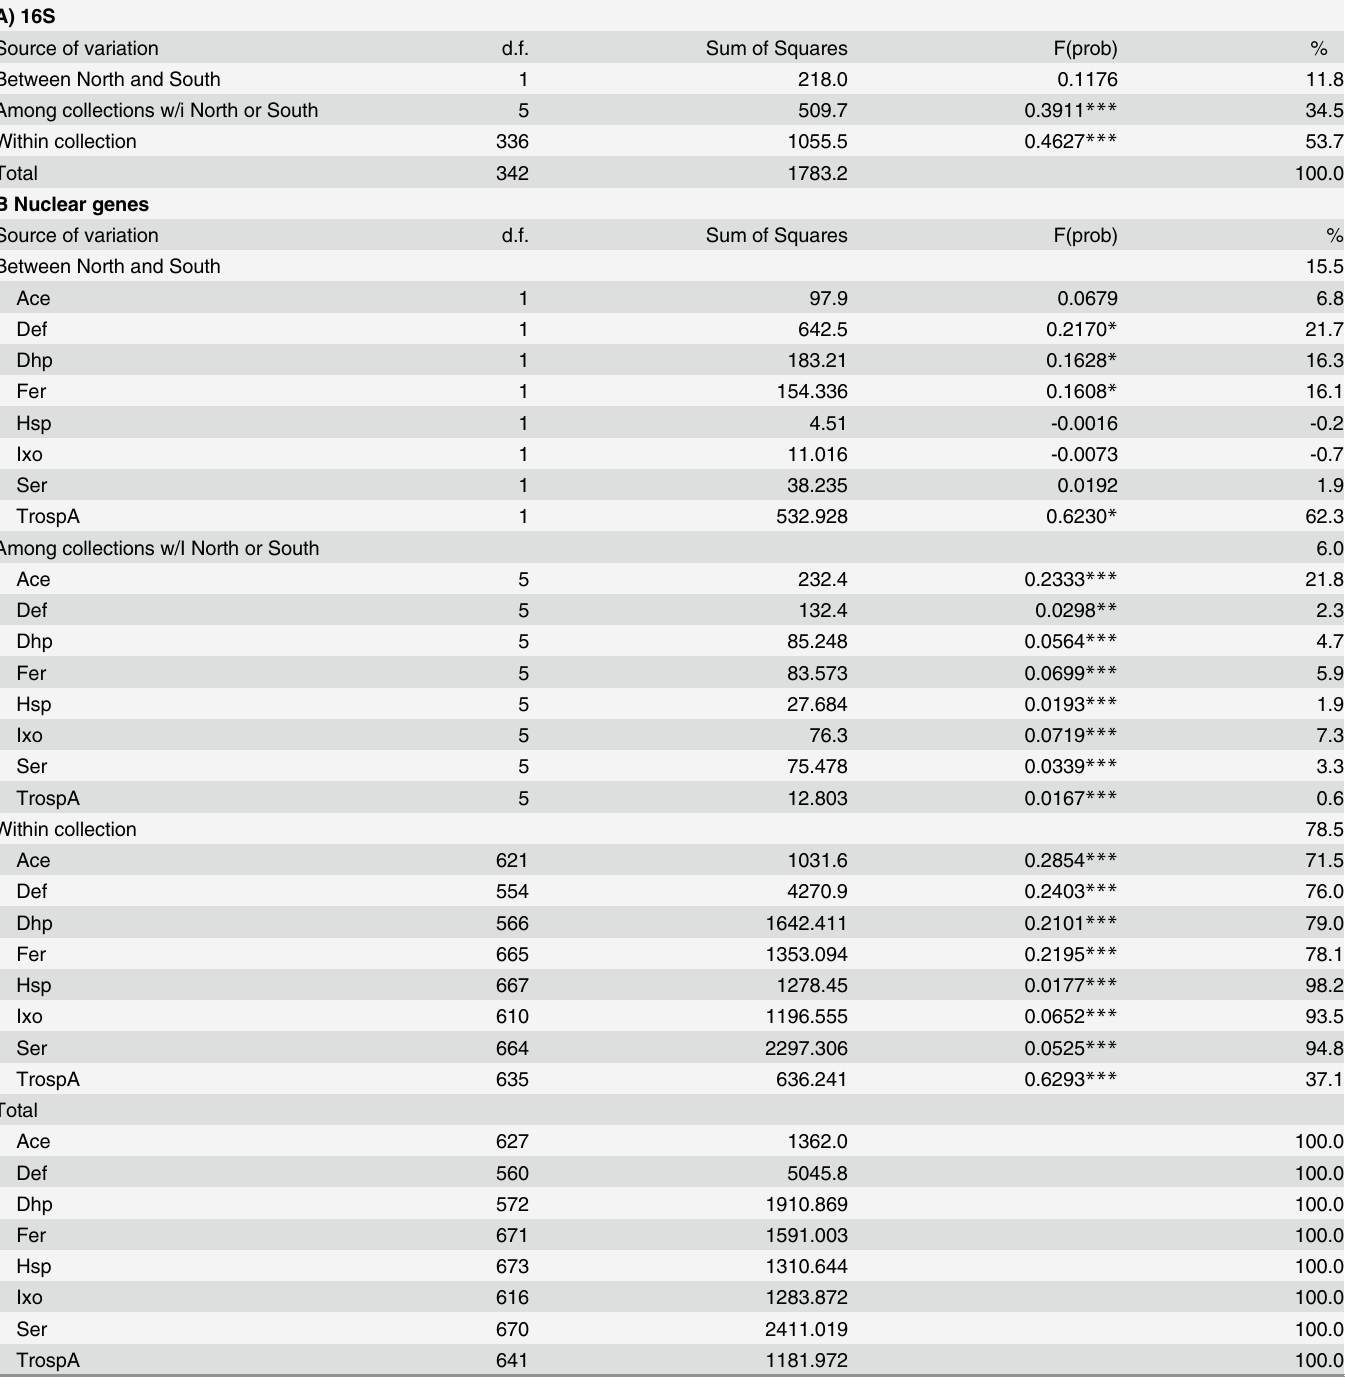
Table 4. Analysis of molecular variance comparing variation between and within our northern and southern collections of Ixodes scapularis . Sig- nificant P values are highlighted in